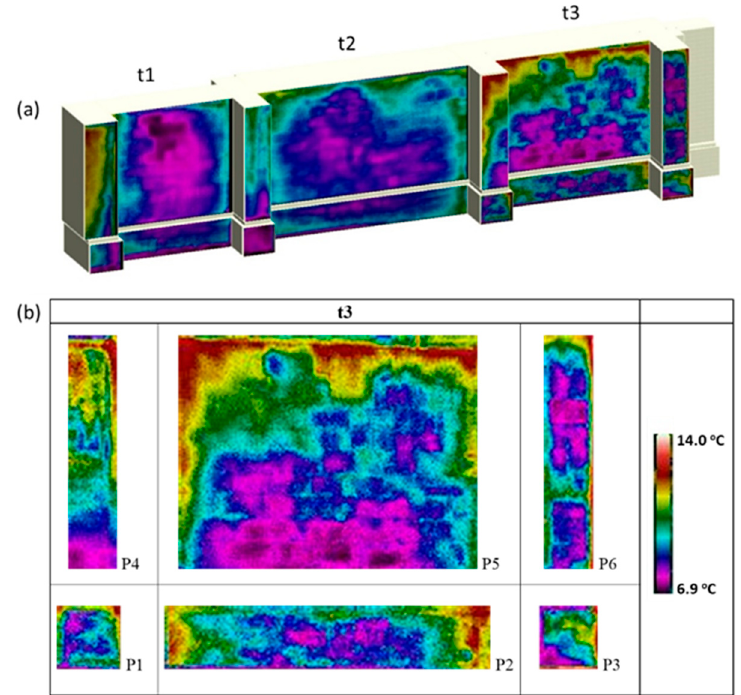
Figure 10. Infrared thermography of the study area: ( a ) areas t1, t2 and t3 of the Founder’s Chapel; ( b ) thermographic images for area t3.